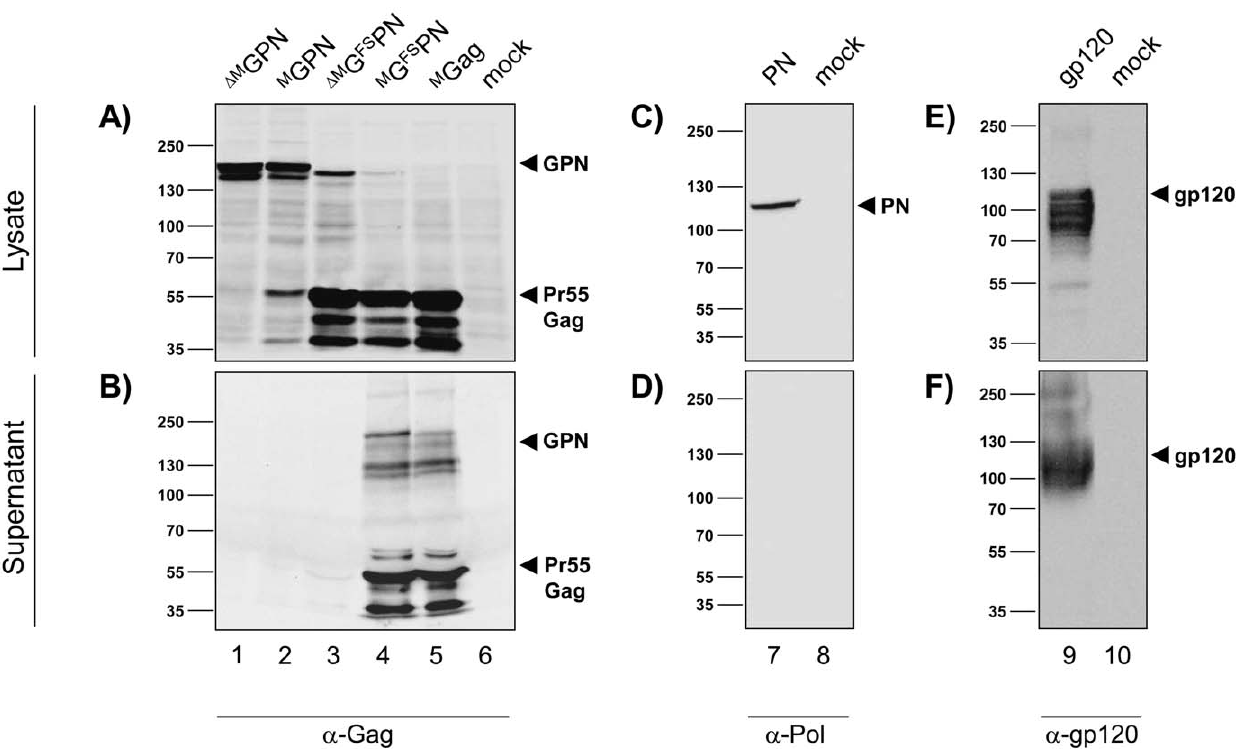
Figure 2. Protein expression from the modified constructs. 293T cells were transiently transfected with the indicated plasmid DNA constructs using jetPEI. Cells and supernatants were harvested after 48 h. Cell lysates, and supernatants processed by TCA/acetone precipitation, were separated by 8.0% SDS-PAGE and analyzed by immunoblotting using p24-specific (Gag) mouse mAb (CB-4/1), HIV-1 RT (Pol)-specific mouse mAb (5B2B2), and gp120-specific mouse mAb (MH23) to specifically detect the corresponding recombinant polypeptides. Molecular weight markers and positions of the specifically detected proteins are indicated. mock: non-transfected 293T cells.